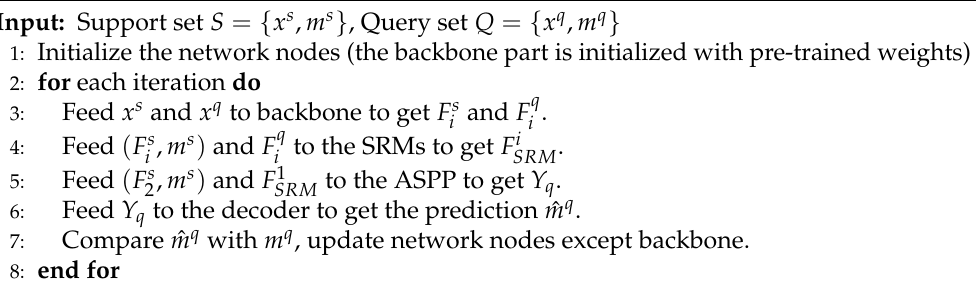
Algorithm 1 The main process of training multilevel features-guided